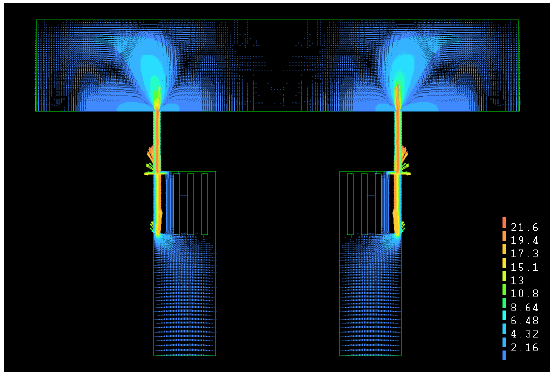
Fig. 6. Velocity vector profile of micro airflow in the neutral position